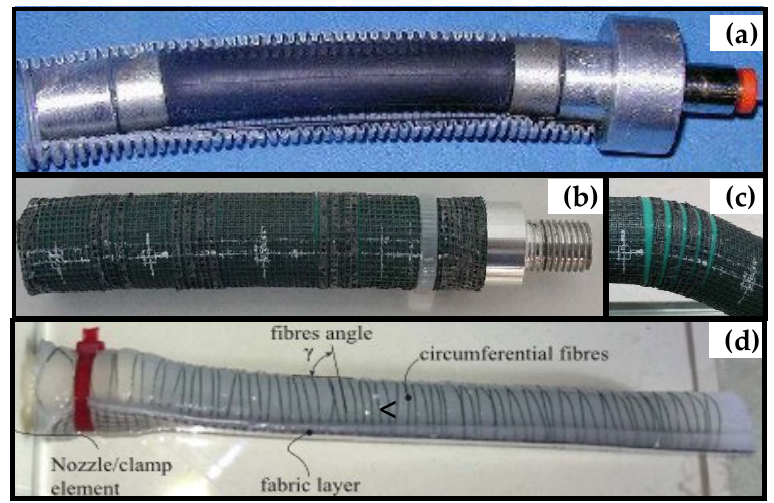
Figure 7. Bending actuators prototypes with one chamber (( a ) [35], ( b ) and ( c ) [48], ( d ) [30]). On the other hand, the prototype developed by Antonelli et al. [48], shown in Figure 7b,c consists of an internal tube in hyper-elastic silicone rubber wrapped in a polyamide inex- tensible square-mesh gauze. The latter has some cuts perpendicular to the actuator axis, which guide the bending of the actuator. The kinematics of the actuator and the bending angle θ depend on the supply pressure p , the diameter and thickness of the inner tube, and the geometry of the gauze cuts (the angular extension of the uncut sector in correspondence to the cut region α ; the axial length of the cut openF ) according to the predictive formula given in Equation